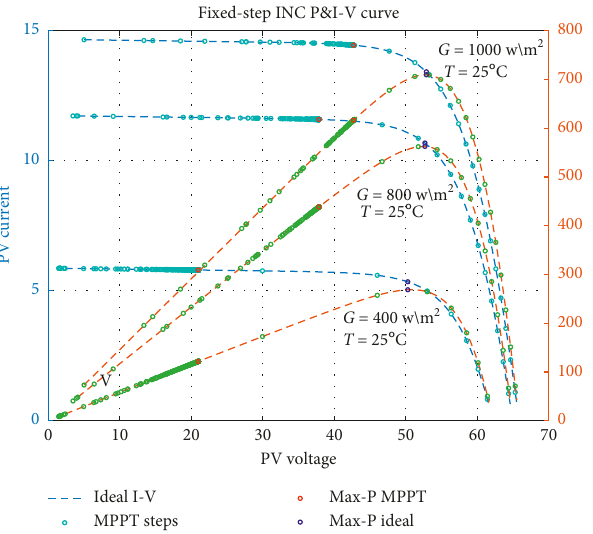
Figure 9: Fixed-step INC I-V and P-V curves.